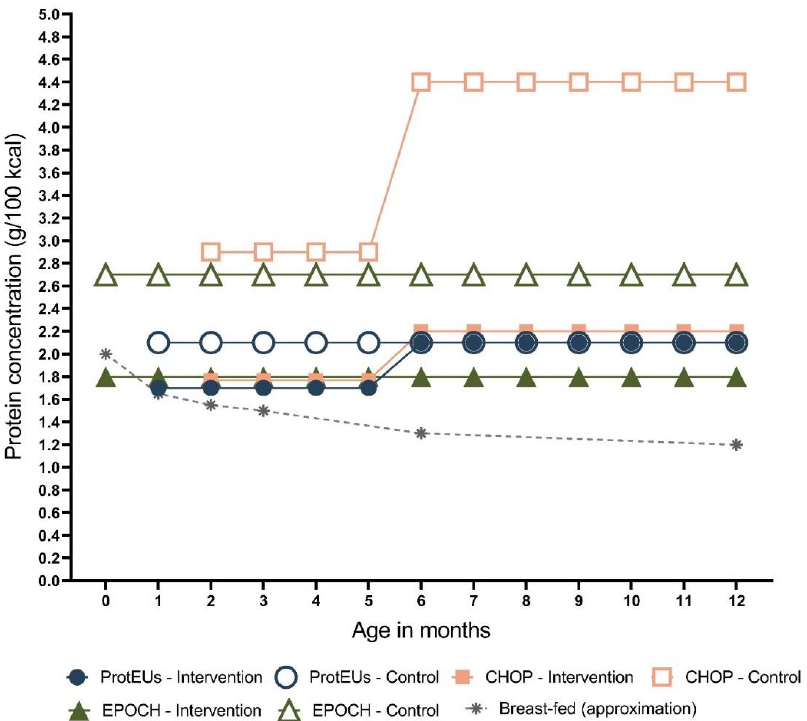
Figure 2. The protein concentrations of formulas used in CHOP [23], EPOCH [27], and ProtEUs [10] during the first 12 months of life (from 6 to 12 months, formula-fed infants in the ProtEUs were fed with standard follow-on formula). The protein concentrations in breast milk were adapted from a systematic review and meta-analysis of the nutrient content of term breast milk [28]. Growth in Breastfed and Formula-Fed Infants Even by lowering the protein levels, differences in growth, weight gain, and body composition are still found when comparing formula-fed infants to breastfed infants. In the ProtEUs study, the total fat mass, total fat-free mass, and fat-free mass index (FFMI) were significantly higher in both formula groups versus breastfed infants until the age of 6 months [10]. At the age of 2, significant differences were found in body composition between the children fed with low-protein infant formula and the breastfed reference group. In contrast, feeding children a standard infant formula did not result in body com- position differences compared to breastfed children [11]. Contrary to these findings, the high-protein group included in the CHOP study had a significantly higher body fat per- centage, fat mass index (FMI), and FFMI than the low-protein group at the age of 2 years. Furthermore, the breastfed infants in the CHOP study had the highest body fat percentage compared to both formula groups at that age [29]. The fat mass and fat-free mass (% of body weight) were similar in the formula and breastfed groups included in the EPOCH study at the ages of 1 and 3 years [27]. The mechanisms through which increased protein intake may affect growth and body composition remain to be clarified. As mentioned before, the anabolic hormones insulin and IGF-1 are responsive to fluctuations in protein intake [13] and have growth- stimulating properties [14,15]. Although no short-term associations among insulin, glu- cose, the Homeostatic Model Assessment for Insulin Resistance (HOMA-IR), and body composition have been described during the first year of life; these associations were seen at 2 years of age [12]. This may suggest that the reduction in insulin sensitivity early in life affects body composition at a later age rather than the opposite.